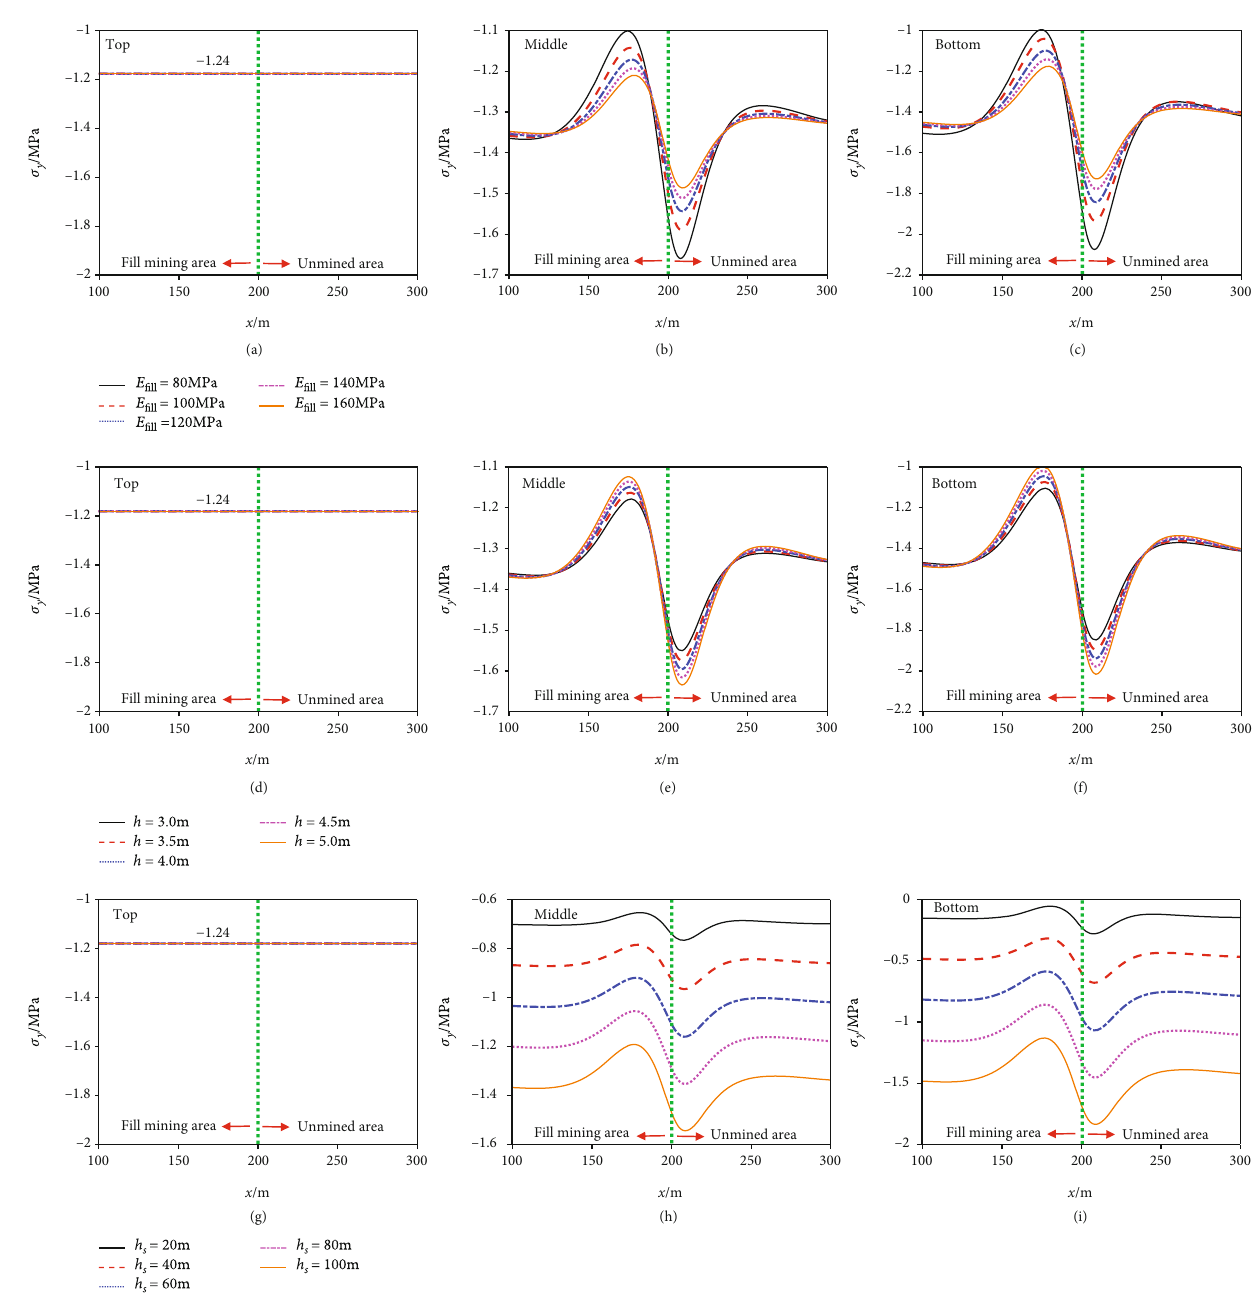
Figure 13: Vertical stress distribution of the key stratum #2 at top, middle, and bottom under various (a – c) E